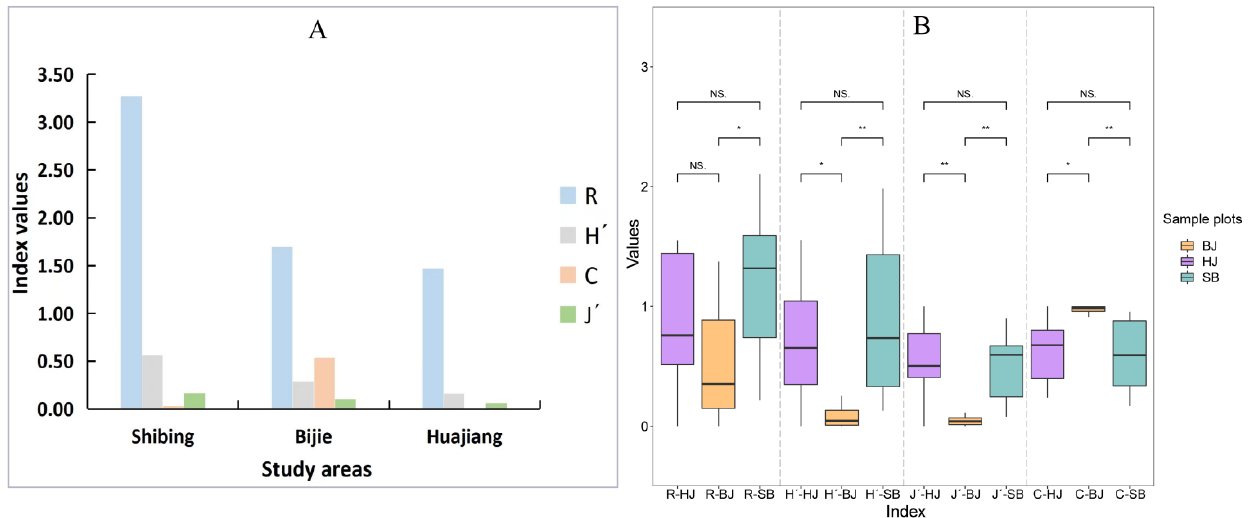
Figure 6. Community diversity of Erythroneurine leafhoppers in three different study areas (( A ): the total values of three study areas. ( B ): the values of nine sample plots of three study areas). *, p < 0.05; **, p < 0.01. R , Margalef Species richness index; H’ , Shannon–Wiener Diversity index; C , Simpson Dominance index; J’ , Pieluo Uniformity index.